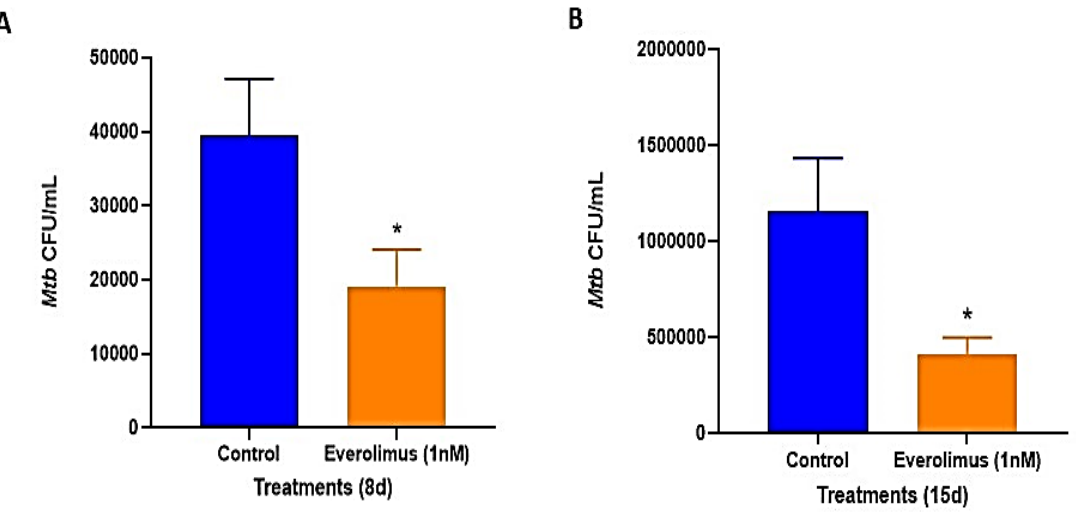
Figure 1: Survival of M.tb. Erdman strain in untreated (control) and Everolimus-treated in vitro granulomas generated from PBMCs isolated from individuals with type 2 diabetes. PBMCs isolated from individuals with type 2 diabetes were infected in vitro with M.tb. Erdman strain and were either untreated (control) or treated in vitro with everolimus (1 nM). Granulomas were terminated at 8-days (Figure 1A) and 15-days (Figure 1B) post-infection. Cell-free supernatants were collected and stored. Granulomas were lysed with ice-cold PBS. Supernatants and granuloma lysates were plated on 7H11 agar plates containing ADC to determine the survival of M.tb